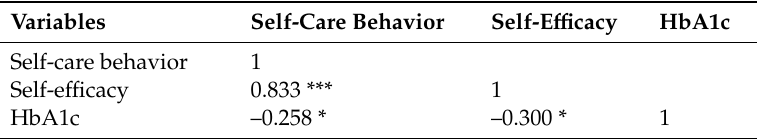
Table 2. Correlations among self-care behavior, self-e ffi cacy, and HbA1c